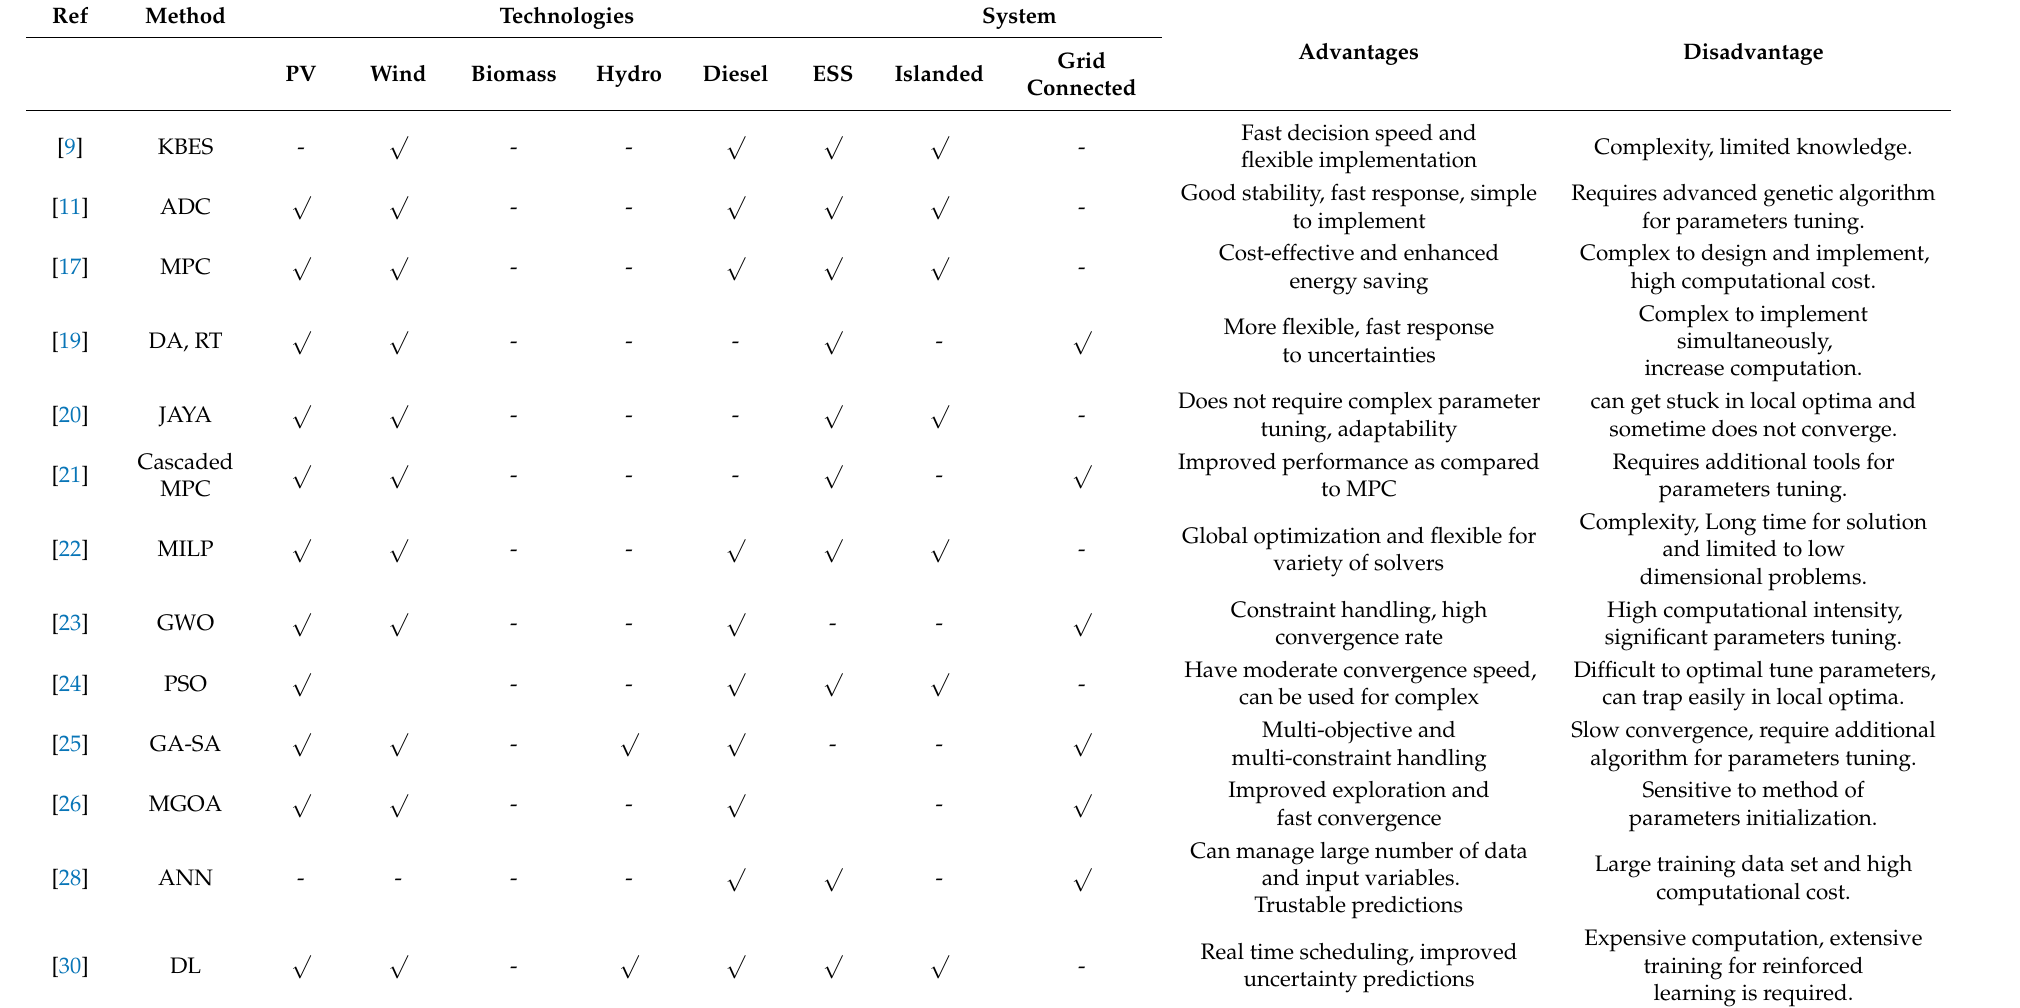
Table 1. Literature